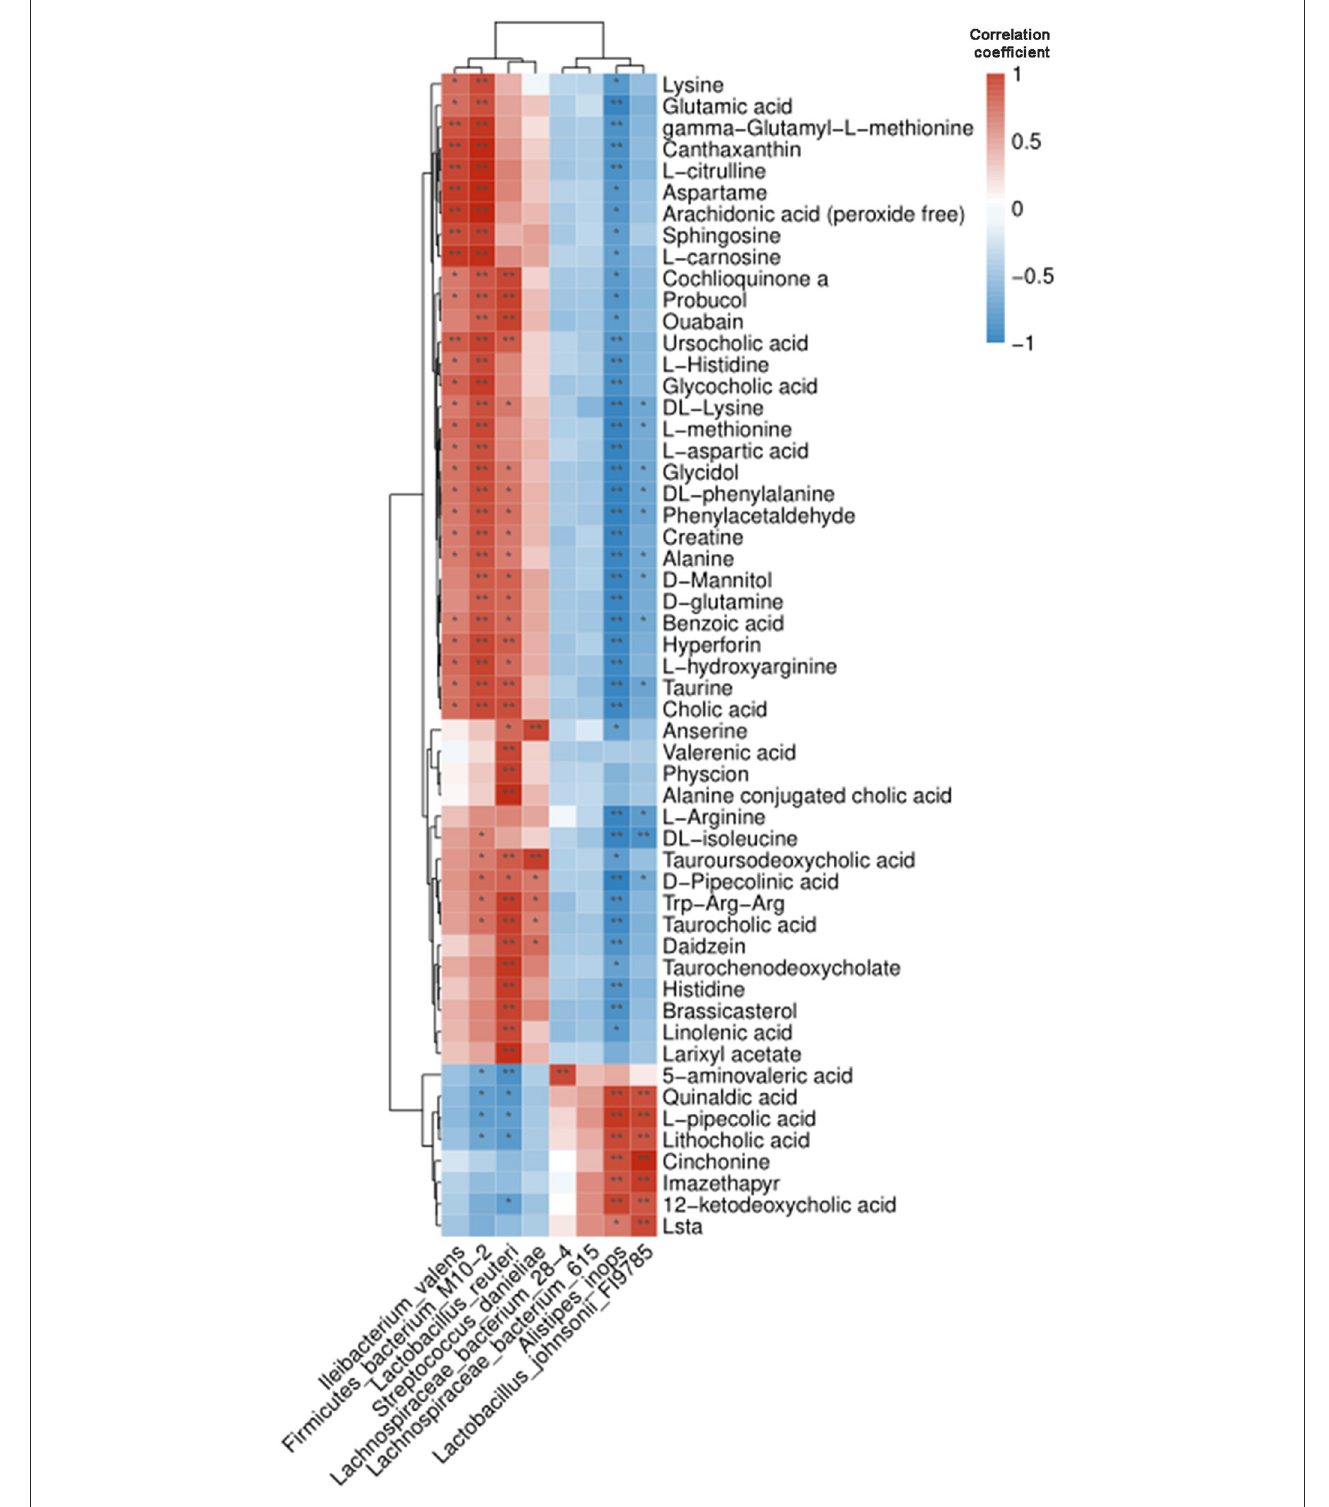
FIGURE5 Pearson correlation analysis of intestinal microbiota and metabolites in BPA mice. The cluster heat map showed their correlation. Blue and red represented the negative and positive correlation, respectively. * P < 0.05, ** P < 0.01.